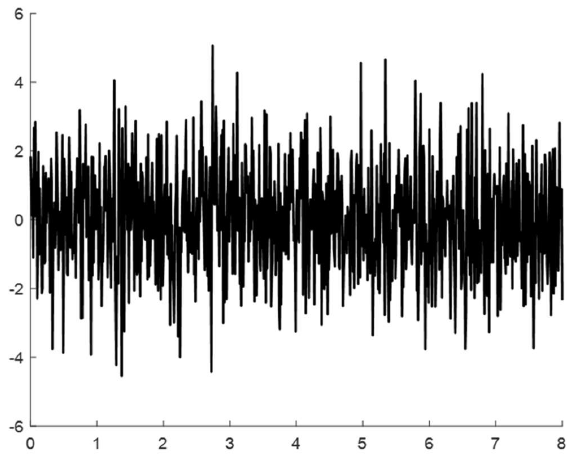
Figure 6. Gaussian noise simulation diagram.